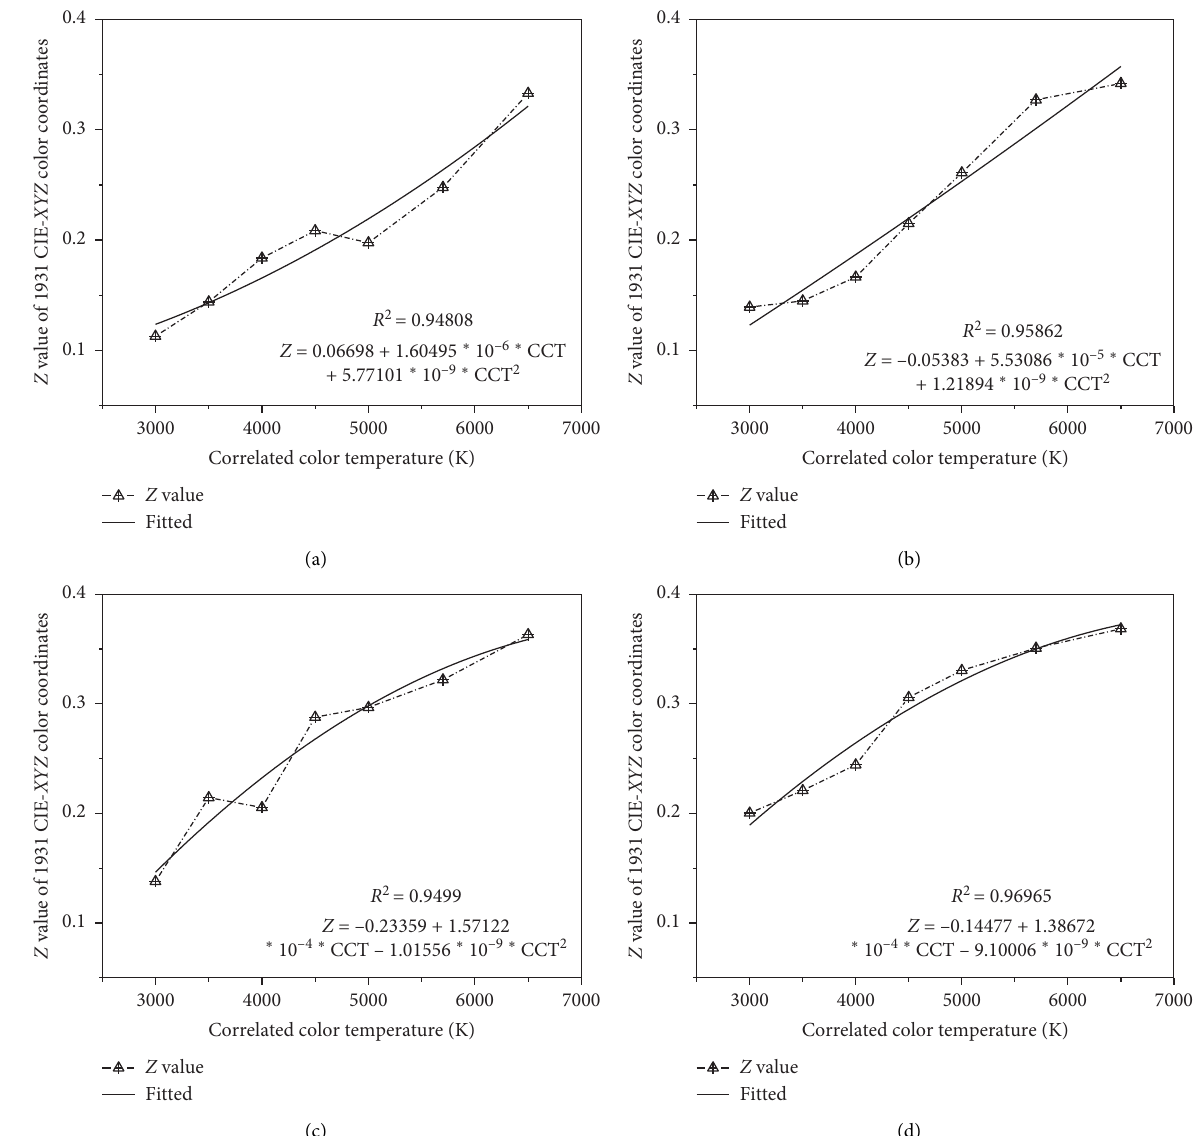
Fitted Figure 2: Z -value of 1931 CIE- XYZ color coordinates. (a) CRI2012 � 65. (b) CRI2012 � 75. (c) CRI2012 � 85. (d) CRI2012 �